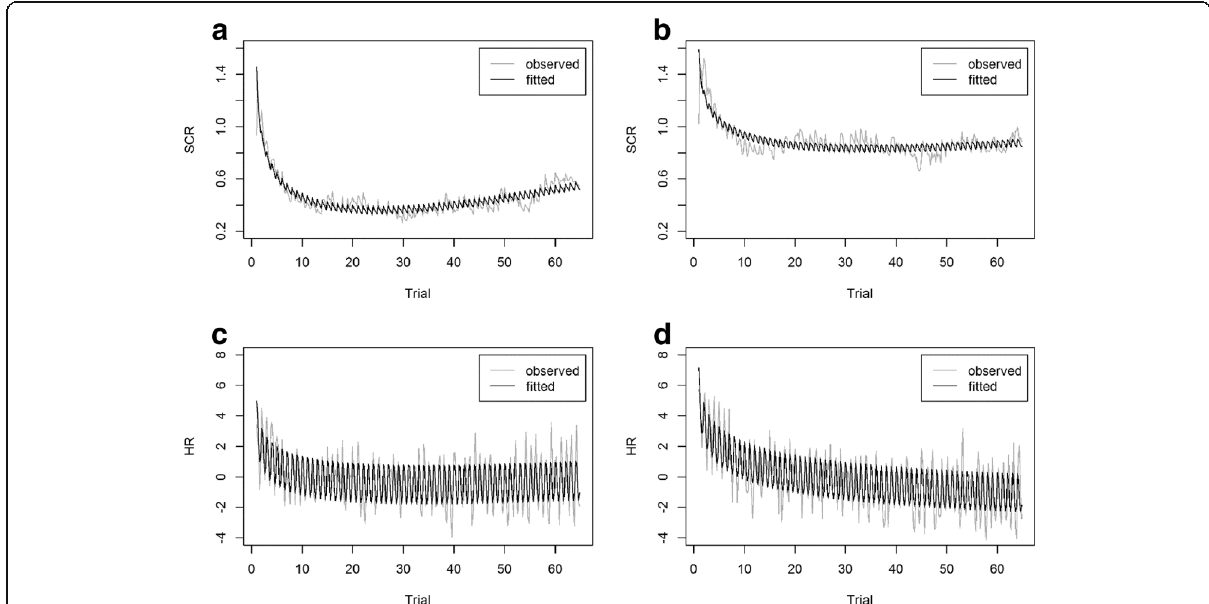
Fig. 7 Observed and fitted logarithmic progressions of SCR and HR over time in easy ( a , c ) and difficult ( b , d ) conditions including both seasonal and trend components